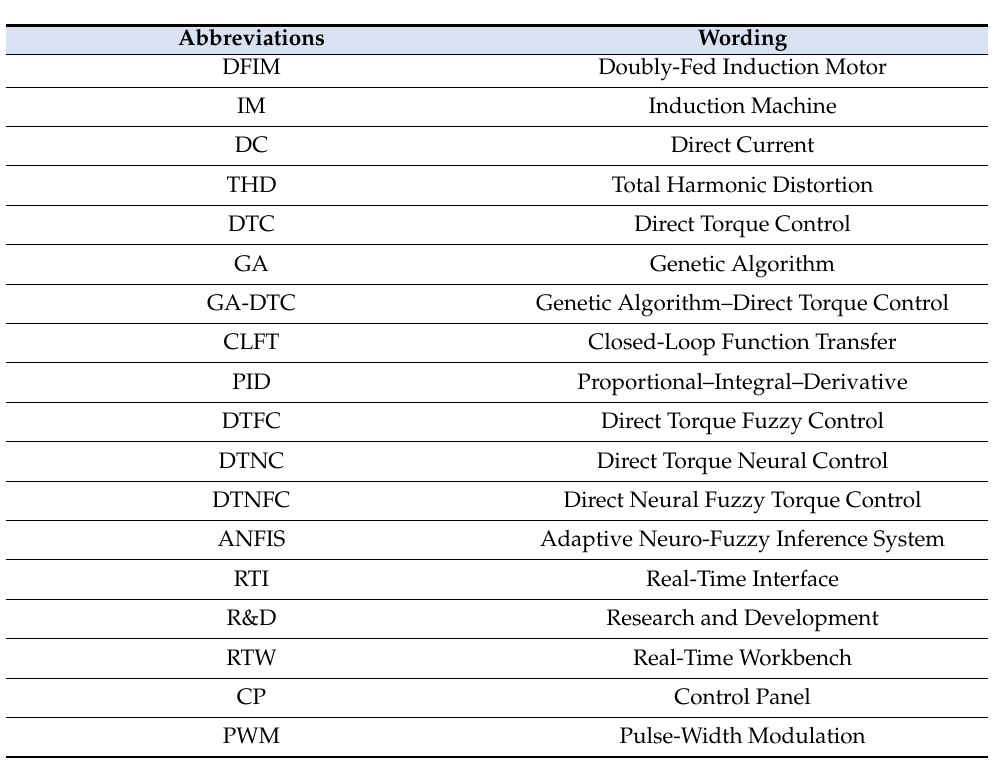
Table A4. Abbreviations